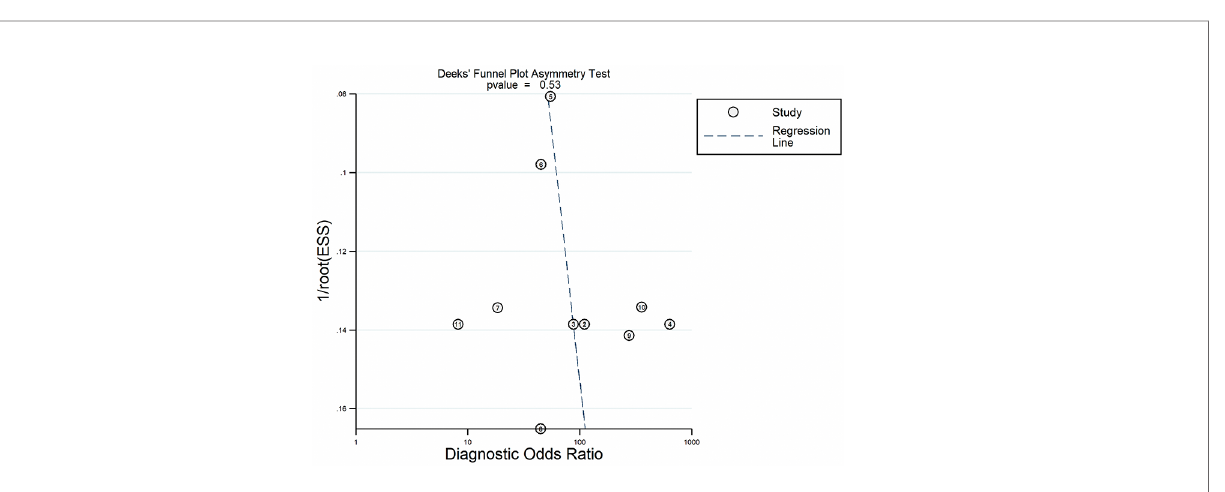
FIGURE 8 | Linear regression test of funnel plot